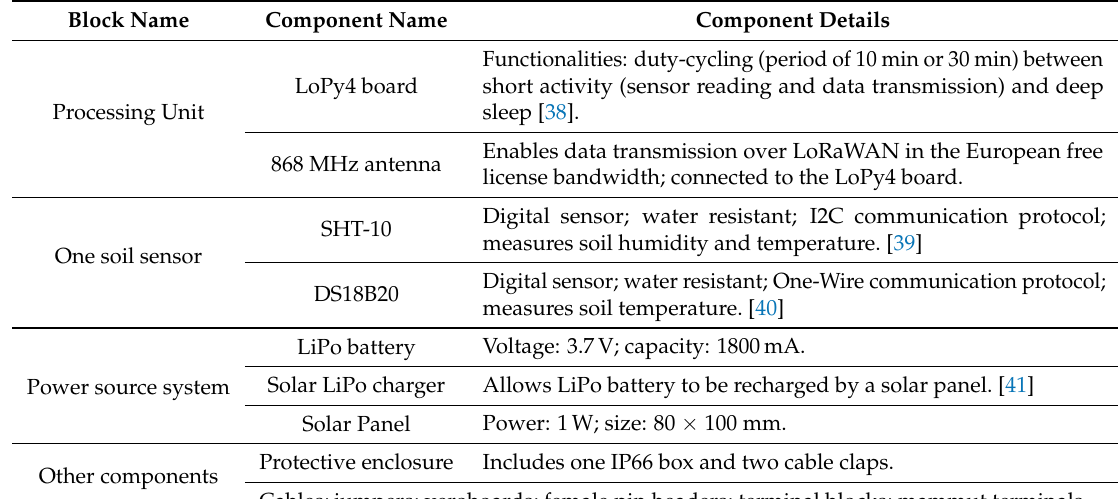
Figure 6. The hardware selected to implement an EN of the vineyard module: ( a ) 868 MHz Antenna; ( b ) LoPy4 board; ( c ) 3.7V, 1800mA LiPo Battery; ( d ) 1W Solar Panel; ( e ) Solar LiPo Charger; ( f ) Soil sensor (i.e., SHT-10 or DS18B20). Table 2. Vineyard module ENs: building blocks and selected